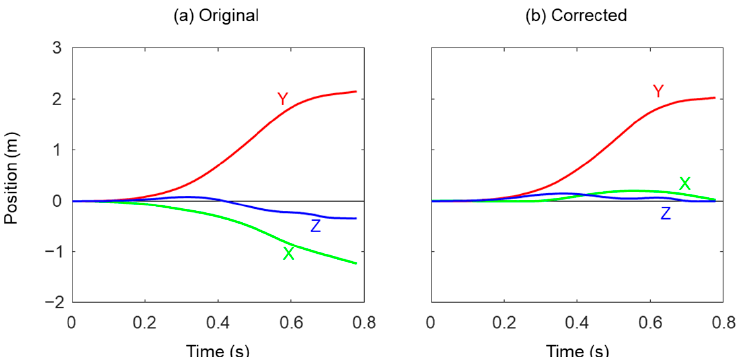
Figure 5. Example of original and corrected foot trajectory obtained from foot mounted IMU of the velocity was used to make both velocities of foot at MS i and MS i +1 zero. The foot trajectory was then calculated from the dedrifted velocity, and the stride length was calculated from the absolute value of the foot position at MS i +1 .